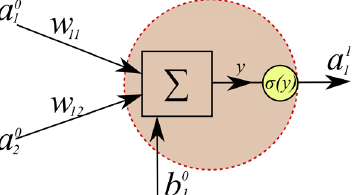
Fig. 13 Representation of a single Neuron. For this example the input , a 0 ) , associated to the neuron are the is described by the vector ( a 0 1 2 , with y = w T . a 0 + b 0 weights w 11 ,w 12 and the bias b 0 1 = σ( y ) i.e. the activation function evaluated at y neuron output a 1 1